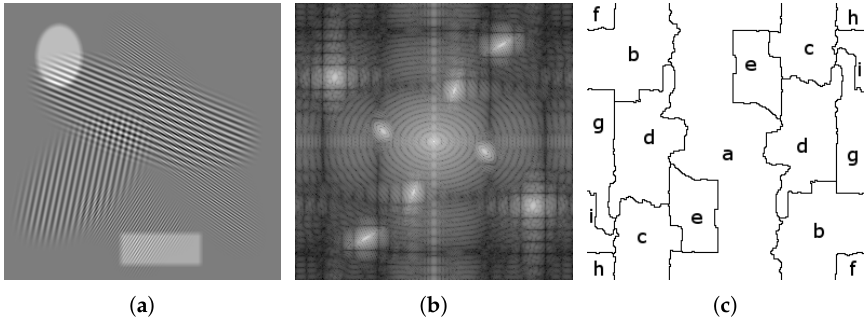
Figure 6. ( a ) An example image, ( b ) its magnitude Fourier transform, ( c ) the detected partition using the